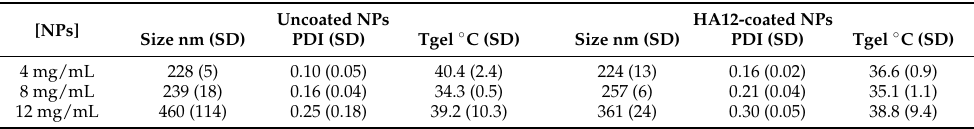
Table 4. Chemico-physical characteristics of NPs at different concentrations, and effect of the concen- tration of NPs on the Tgel of a TSH formulation with 10% P407 and 0.5% HA330.